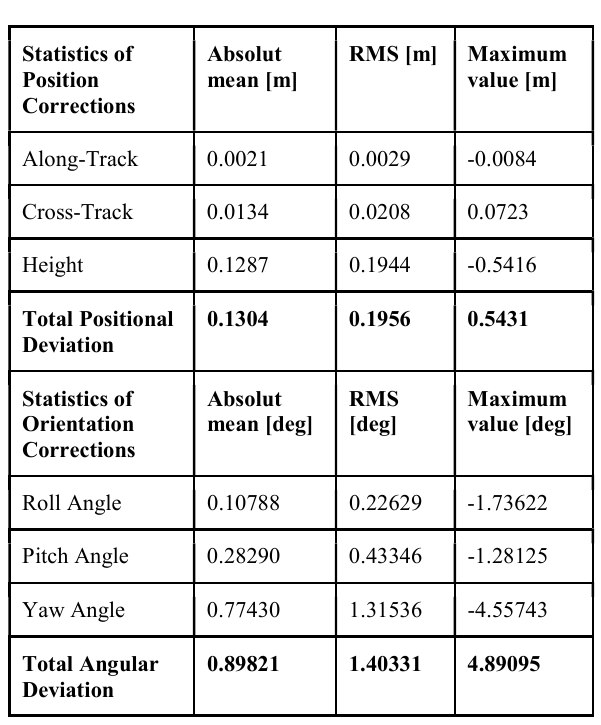
Table 2. Statistics of position and orientation corrections.